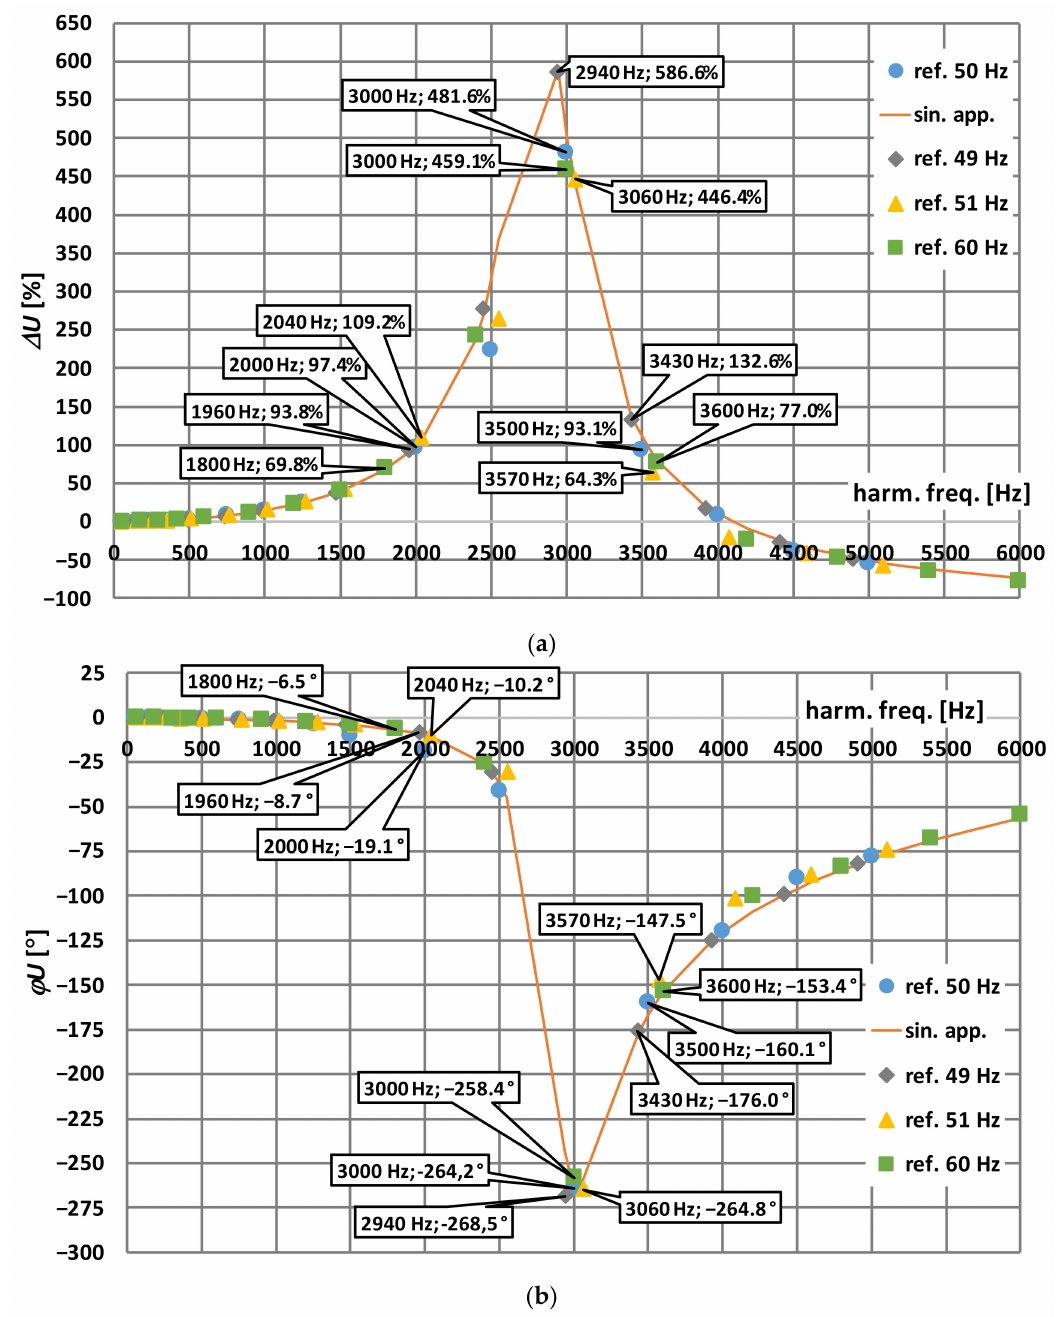
√ 3) kV VT when its secondary winding is loaded with